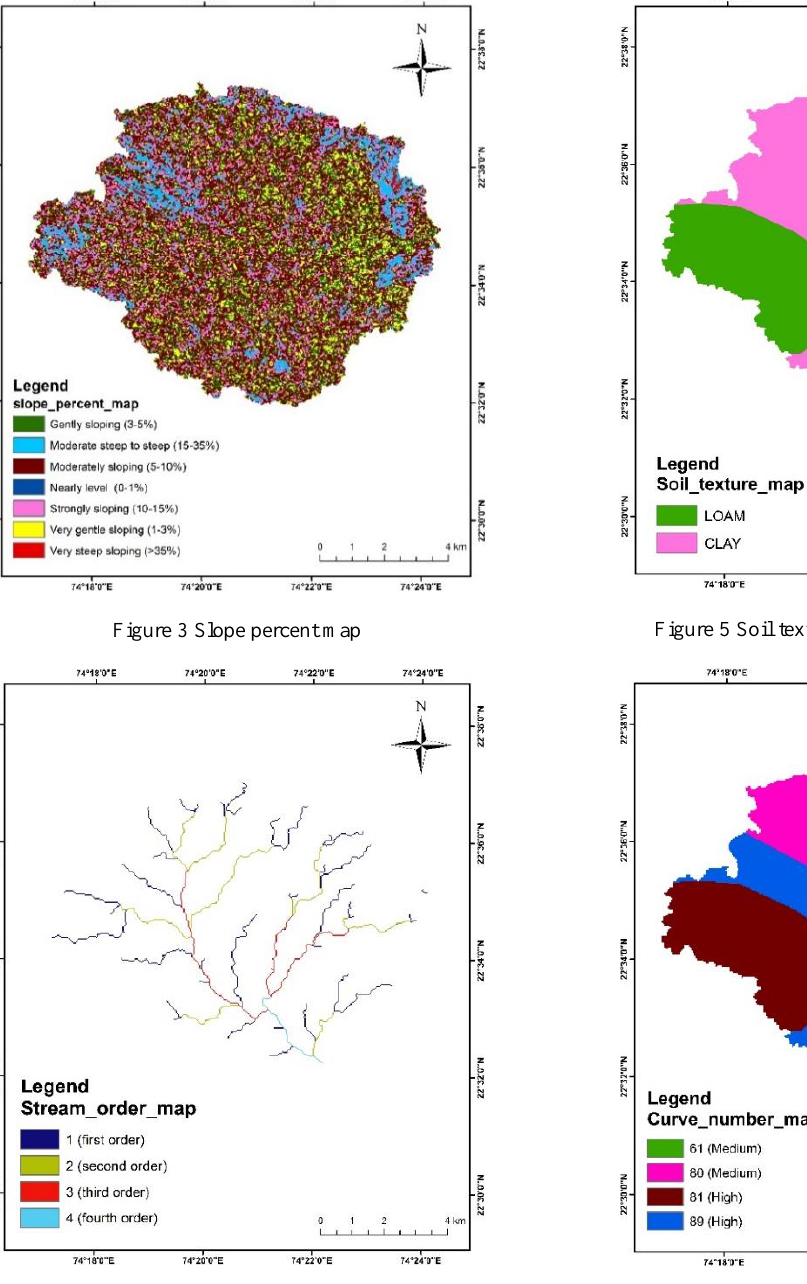
Figure 4 Stream order map of Hatni Sub-watershed